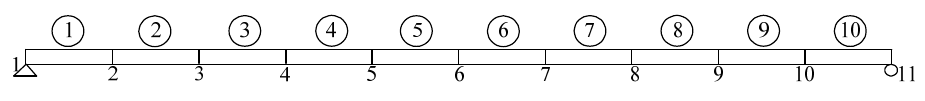
Figure 5. Finite element (FE) model of one span of the bridge with 10 elements.